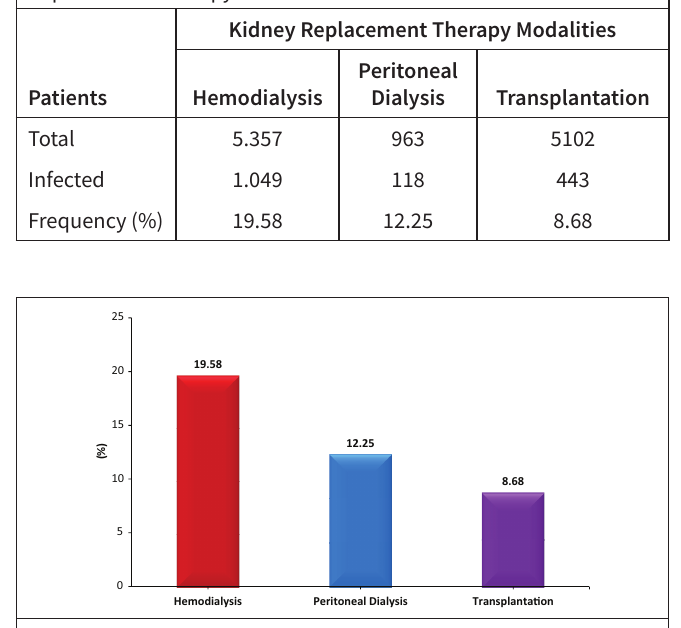
Figure 1. Coronavirus disease 2019 frequency in kidney